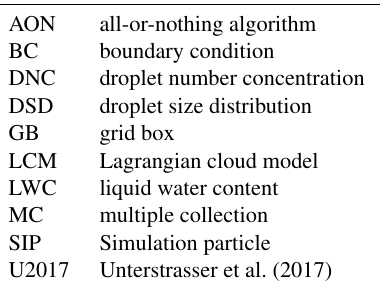
Table 1. List of frequently used